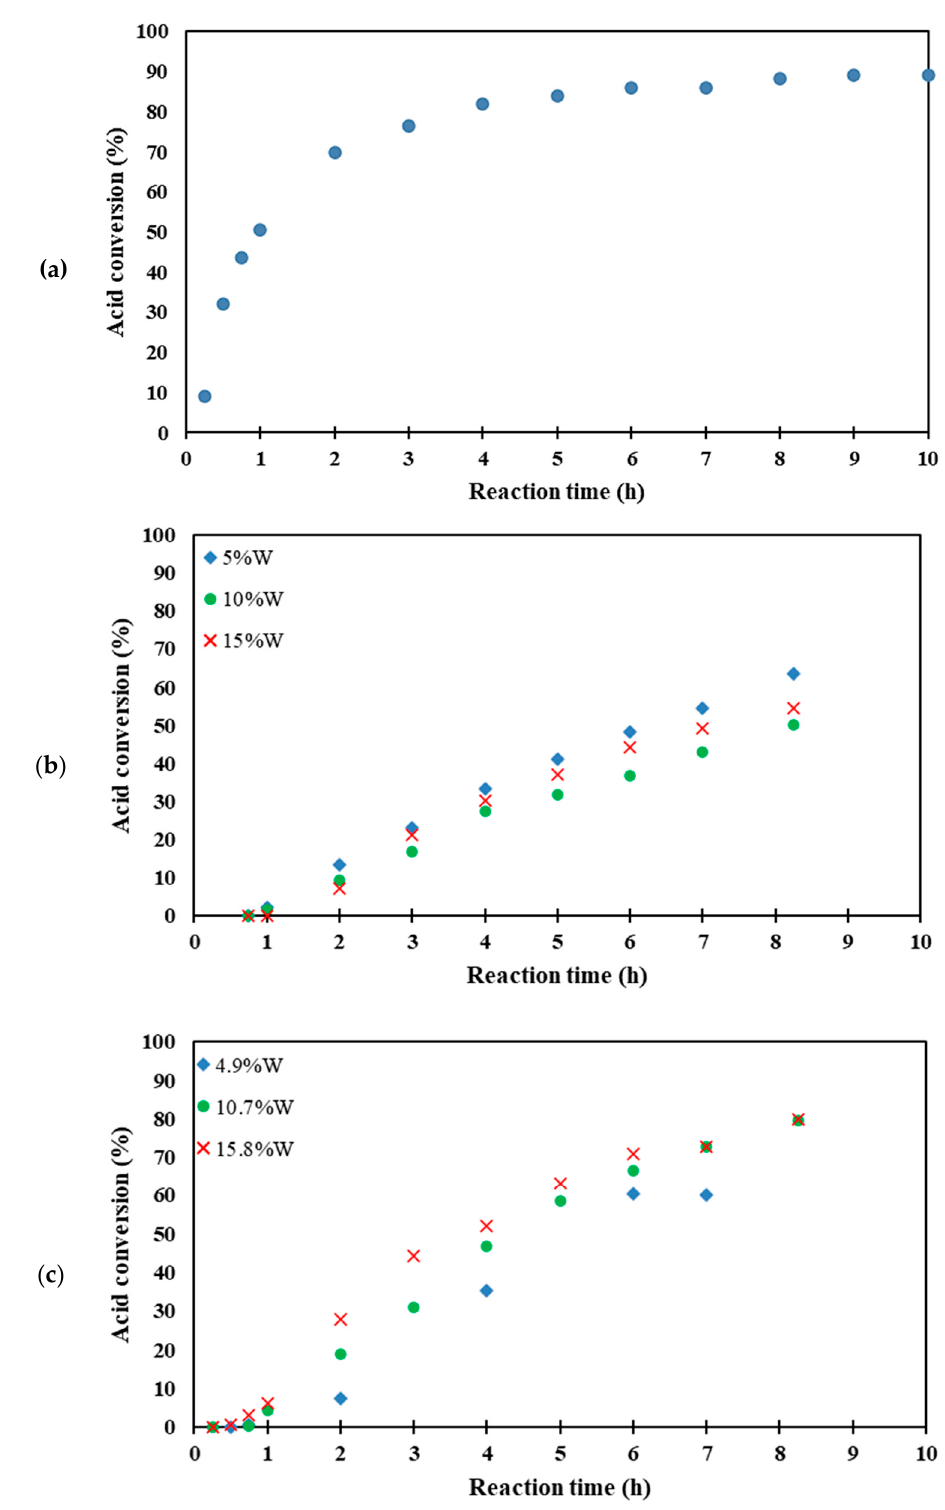
Figure 4. The esterification reaction rate with ( a ) tungstosilicic acid, ( b ) W/A150, and ( c ) W-KIT-5.